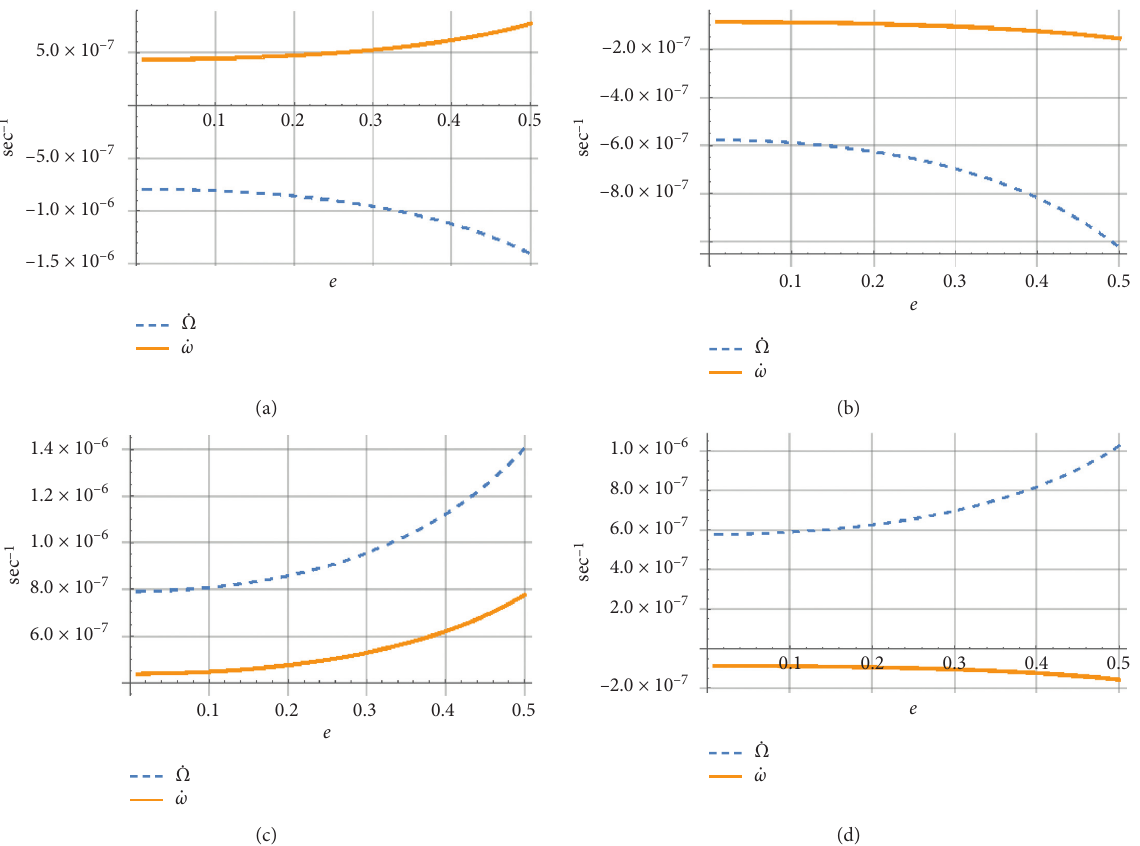
Figure 10: Curves of _ Ω and _ ω with e for the 4 cases corresponding to F ( i ) � 0.15. (a) i � − 55 . 14, (b) i � 65 . 25, (c) i � − 124 . 86, and (d) i � 114 .